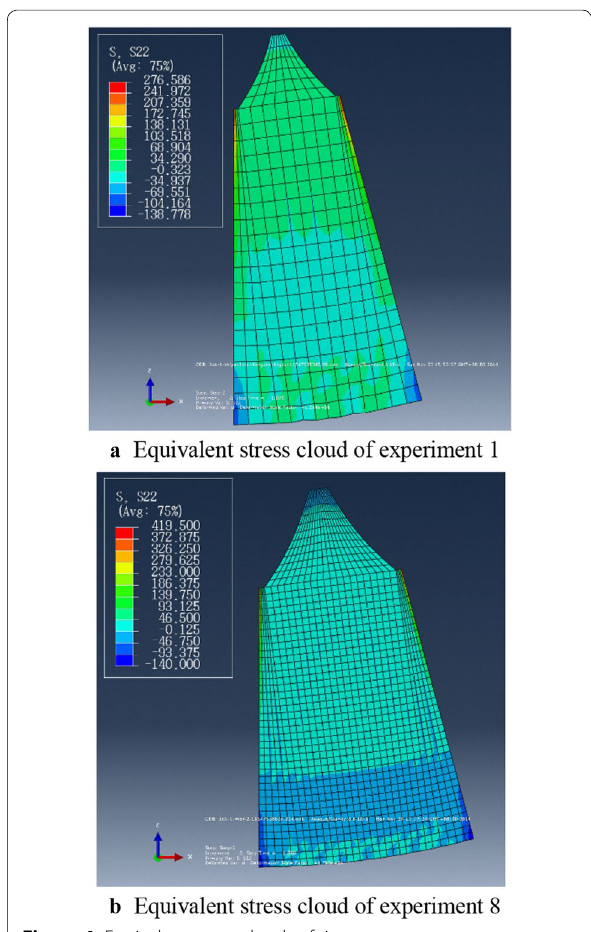
Figure 4 Equivalent stress clouds of ring gear